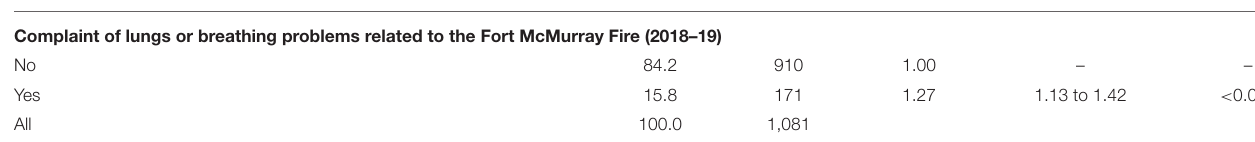
TABLE 2 | Relation of estimated exposure to respiratory symptoms and complaints. Visual analogue “troublesomeness of symptoms”